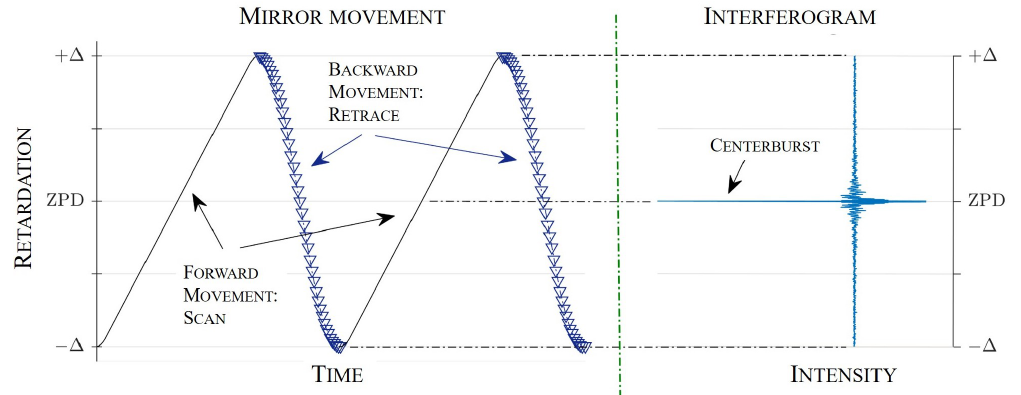
Figure 2. Illustration of the mirror movement for the acquisition of double-sided interferograms. The mirror is scanning only in the forward direction. The movement shape, which, in the illustration,